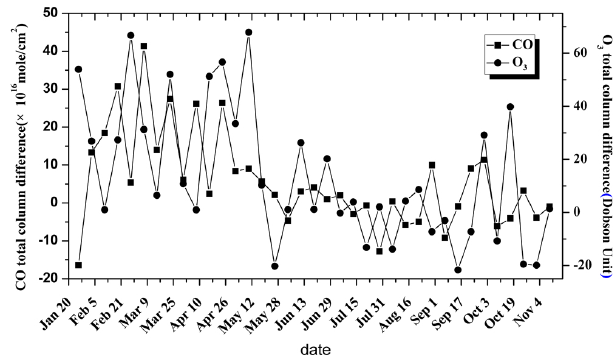
Fig. 4. Variations of differences between 8-day CO and O 3 con- centrations in 2010 and the corresponding 8-day mean values in 2008–2009 in the epicenter area of 5 April 2010 Baja California